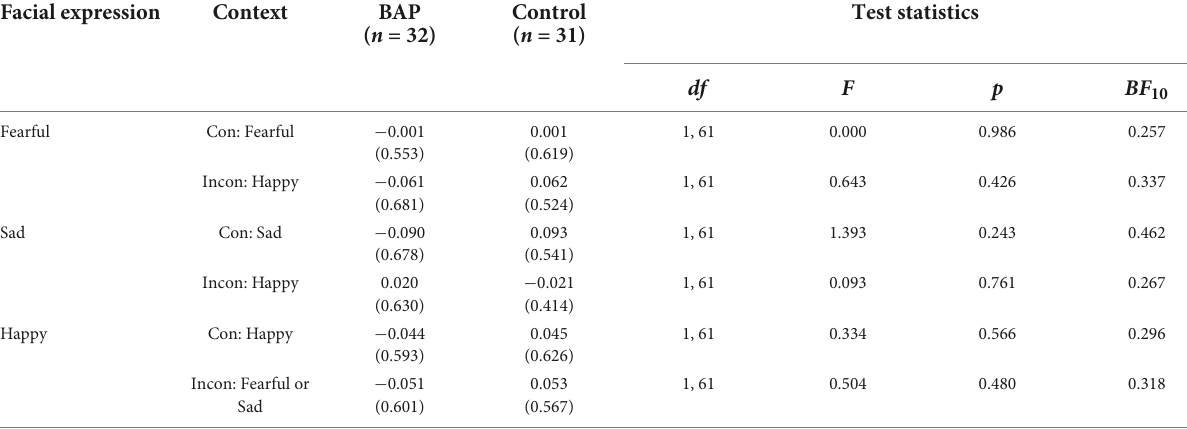
TABLE 5 Mean (SD) of response criteria under each emotion and congruence condition for the groups. Facial